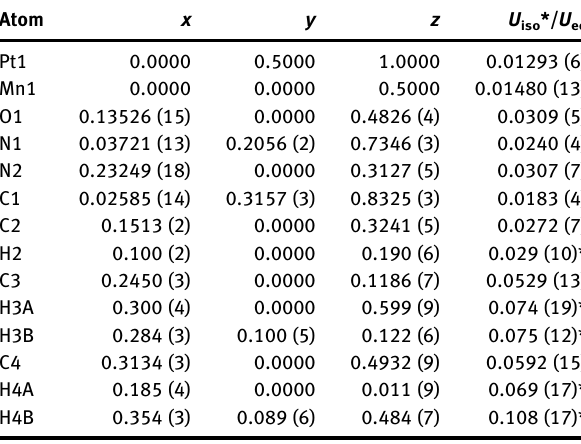
Table  : Fractional atomic coordinates and isotropic or equivalent isotropic displacement parameters (Å 